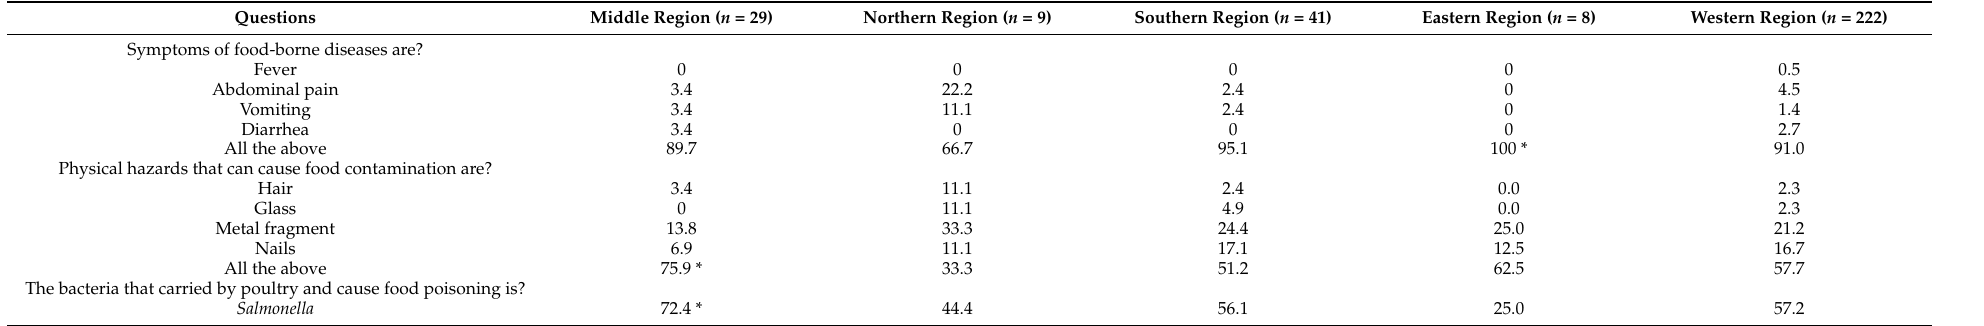
Table 4. Participant’s food safety knowledge based on the region